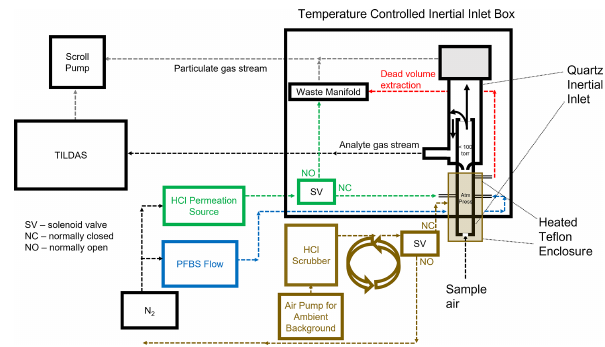
Figure 1. Experimental flow schematic for sampling